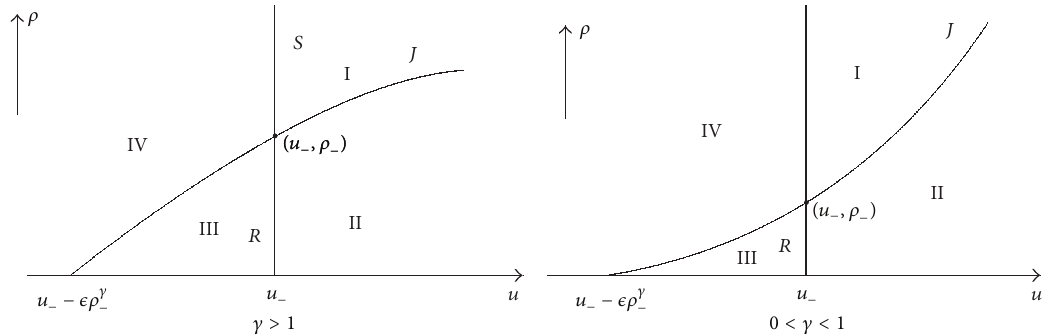
Figure 1: The upper half (𝑢,𝜌) plane with 𝑝 = 𝜌 𝛾 is divided into 4 regions for both cases 𝛾 > 1 and 0 < 𝛾 < 1 .